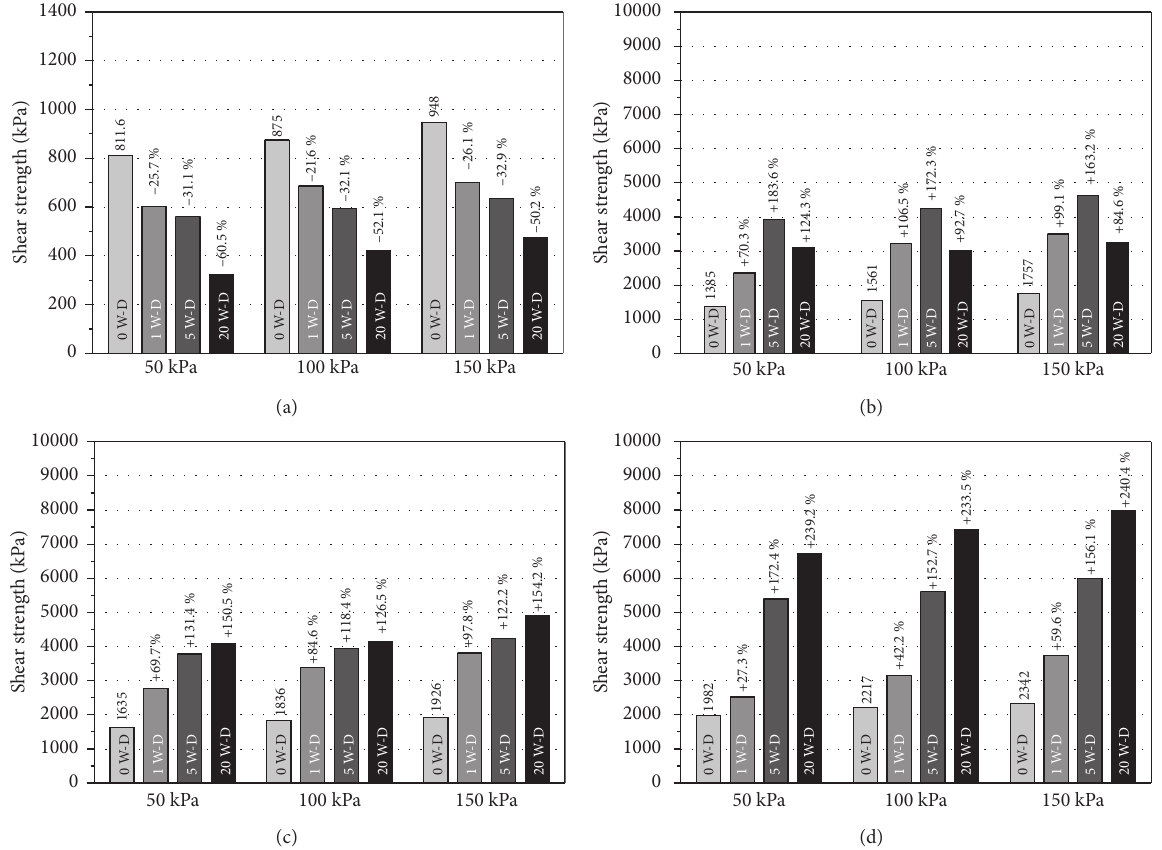
Figure 4: Variations in the shear strength of the untreated and lime-stabilized specimens with the W-D cycles: (a) RAL 0%; (b) RAL 3%; (c) RAL 5%; (d) RAL10%.